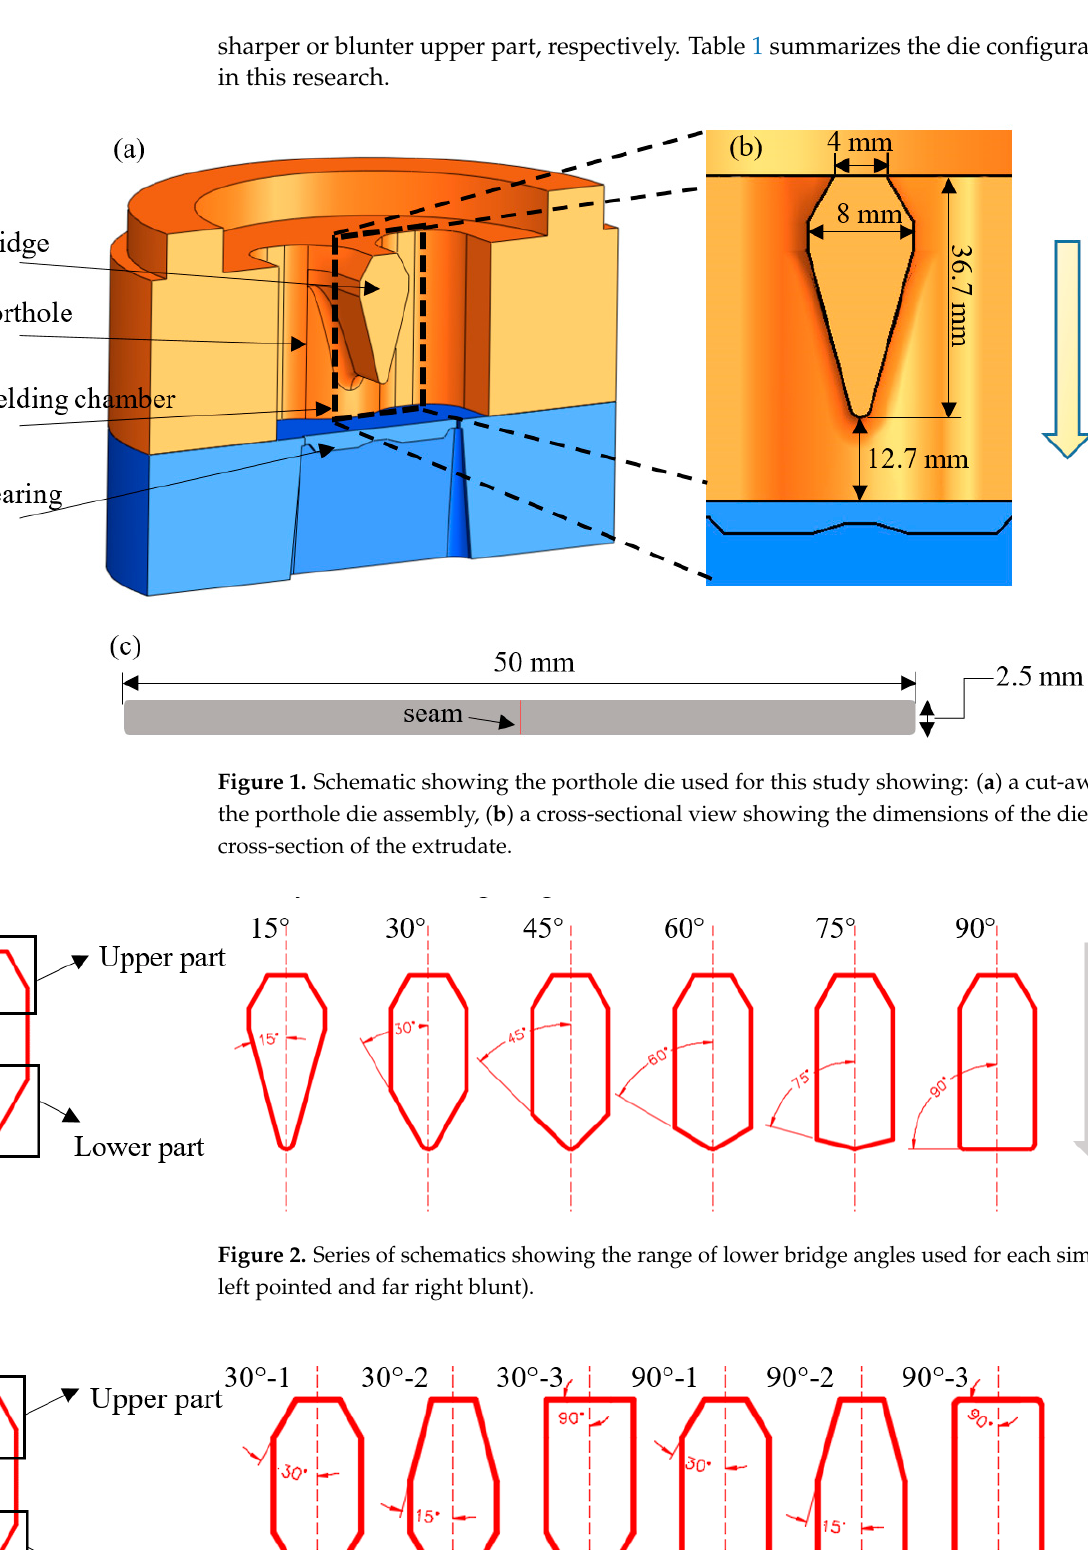
Figure 2. Series of schematics showing the range of lower bridge angles used for each simulation (far left pointed and far right blunt).